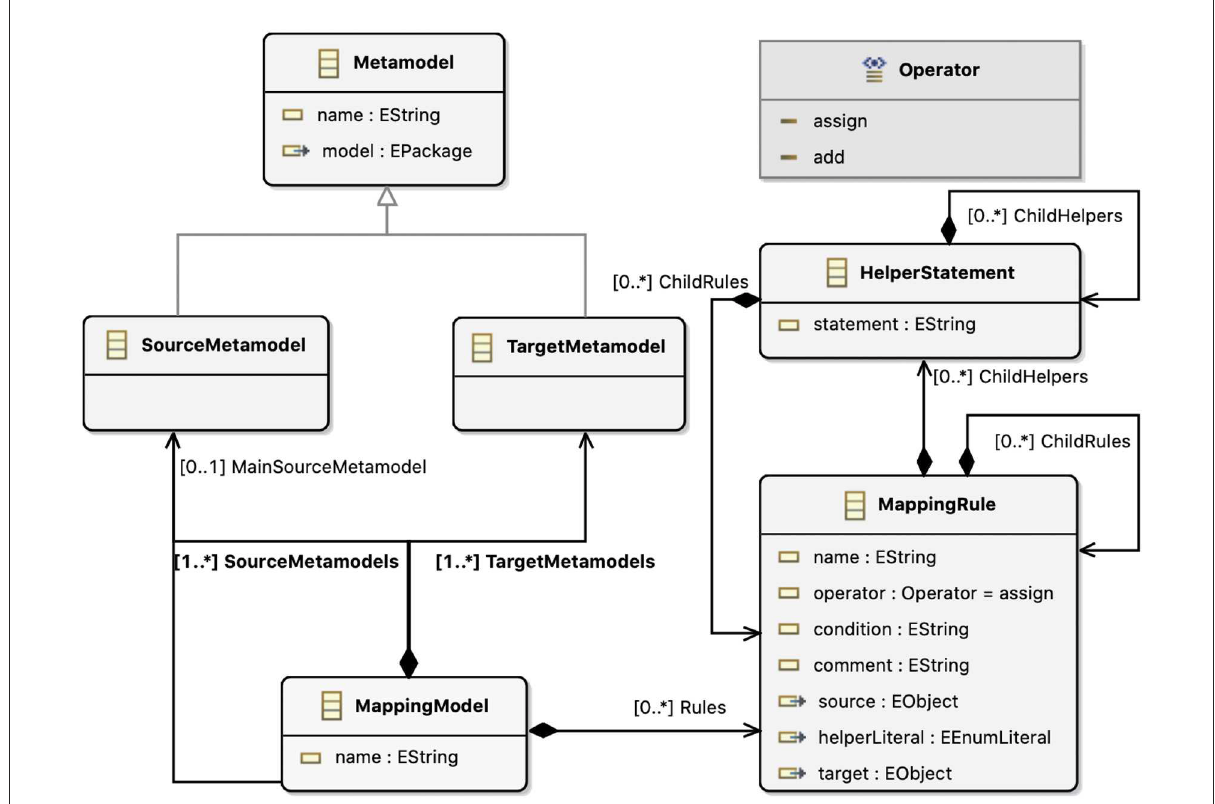
FIGURE2 MML metamodel in Ecore. *Unbounded upperbound for